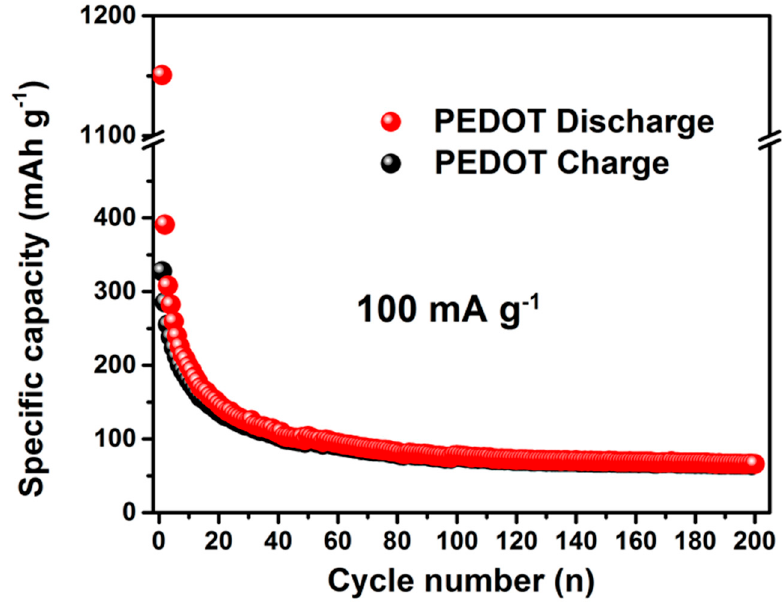
Figure 7. Cycling performance of the pure PEDOT electrode for SIBs at a current density of 100 mA g − 1 .